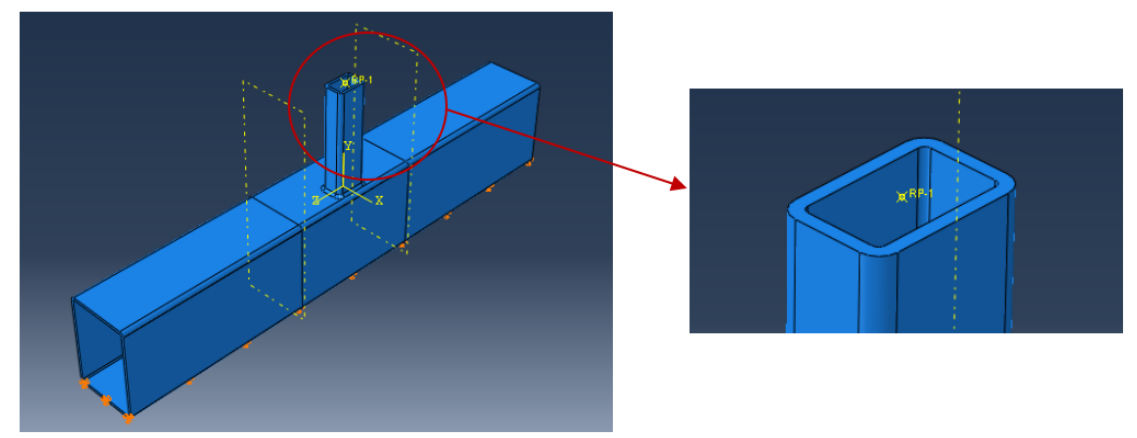
Figure 3. Displacement of the reference point and boundary conditions on the model.